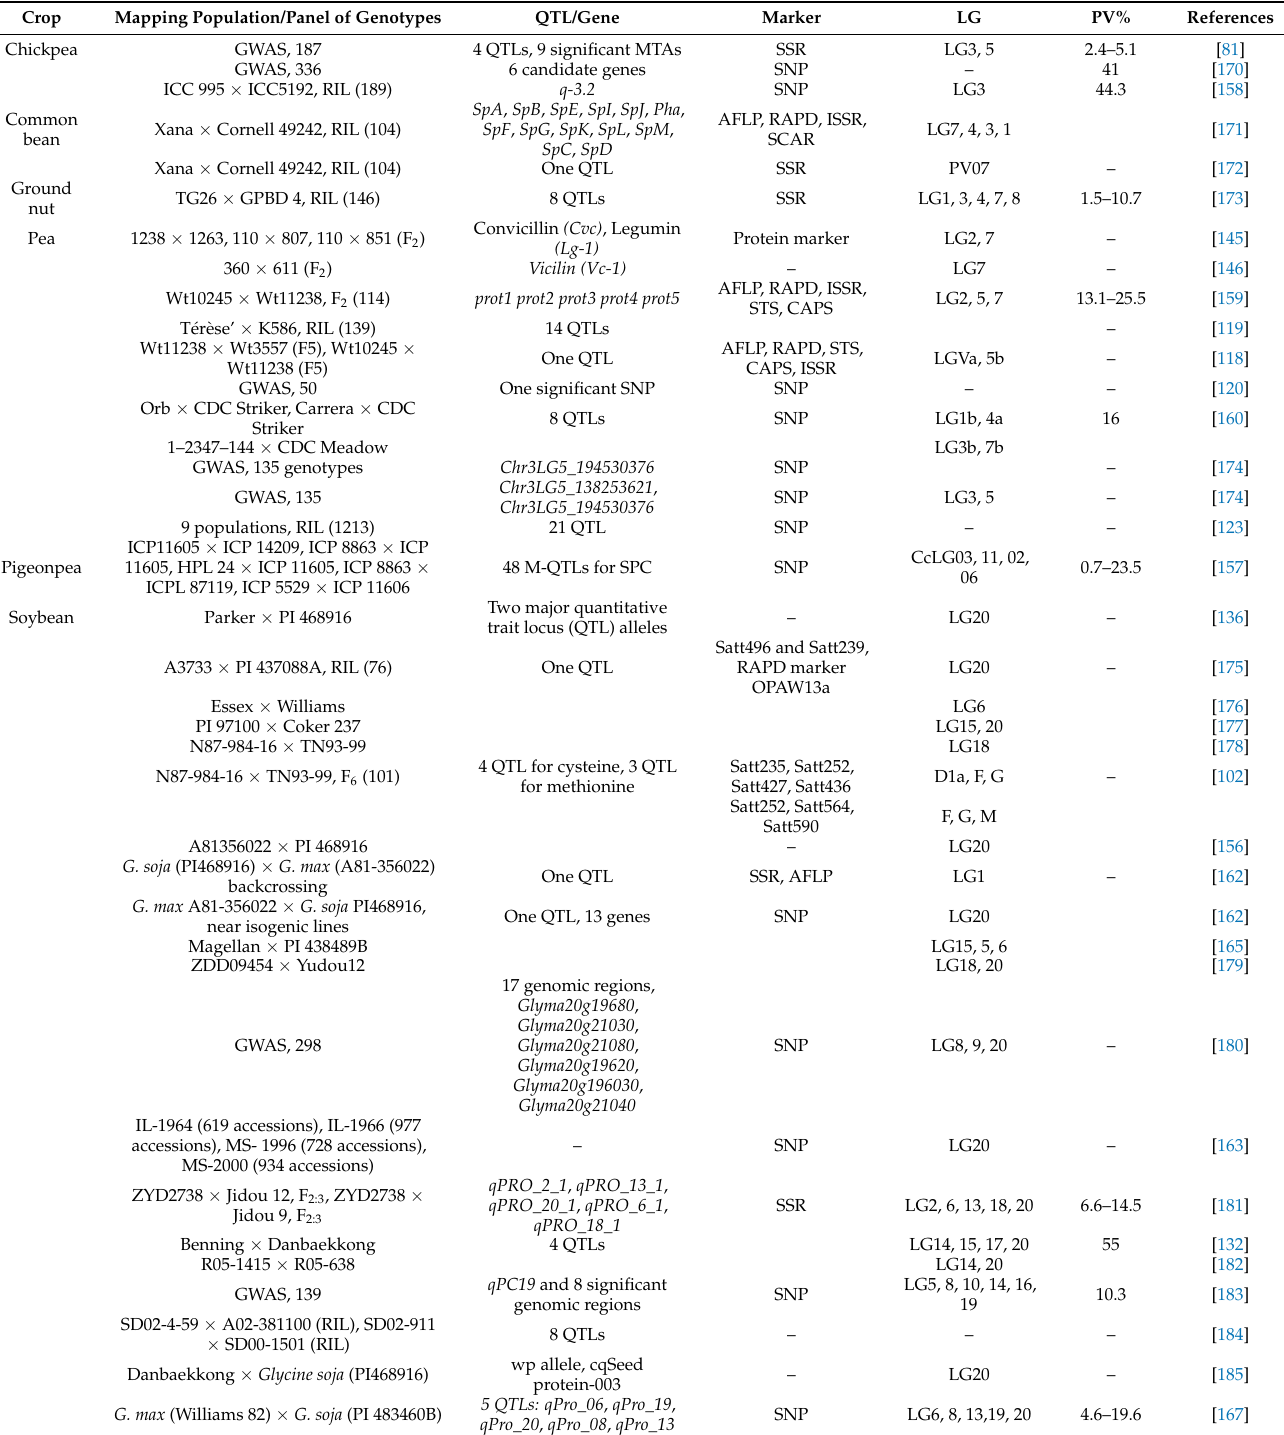
Table 3. List of seed protein content QTLs reported in various grain